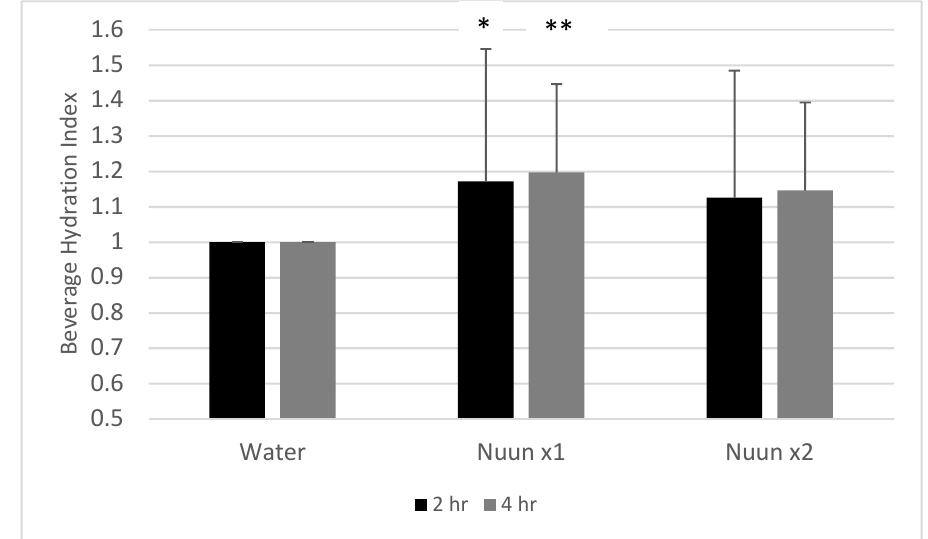
Figure 6. Beverage Hydration Index of 18 men and women at two hours and four hours after consuming water only and Nuun+water; Values are mean ± standard deviation; hr is hour(s) after condition ingestion, Nuun x1 is Nuun beverage at normal concentration, Nuun x2 is Nuun beverage at double concentration; * Water lower than Nuun x1 at 2 hr ( p = 0.05); ** Water lower than Nuun x1 at 4 hr ( p = 0.02); Trend for water lower than Nuun x2 at 2 hr ( p = 0.15) and 4 hr ( p = 0.09); No other differences of statistical significance noted ( p > 0.05).